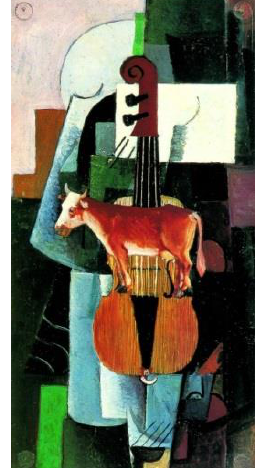
Fig. 28 Cow and violin (Malevich, 1913)